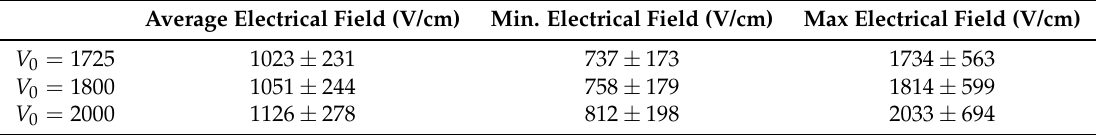
Table 5. Electrical Field Statistics within the Tumor. Varying σ 0 for the tumor.